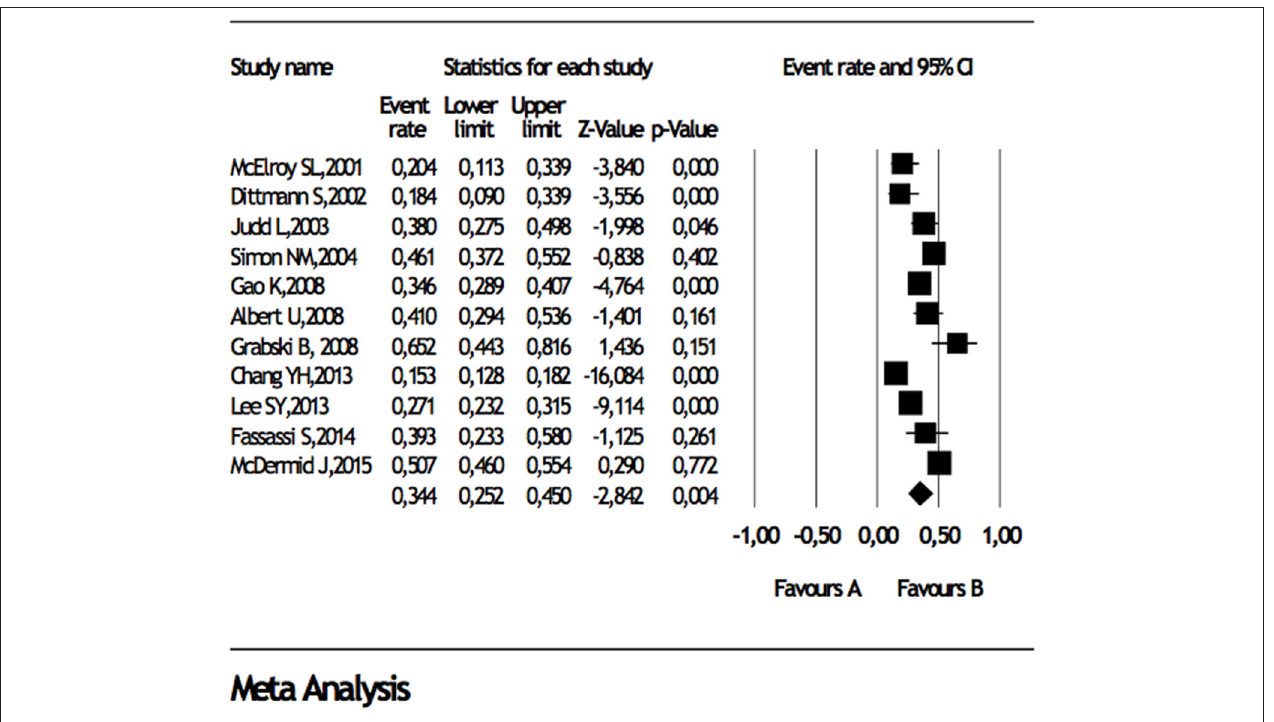
FIGURE 3 | Forest plot for lifetime comorbidity of any anxiety disorder diagnosis in bipolar disorder II.